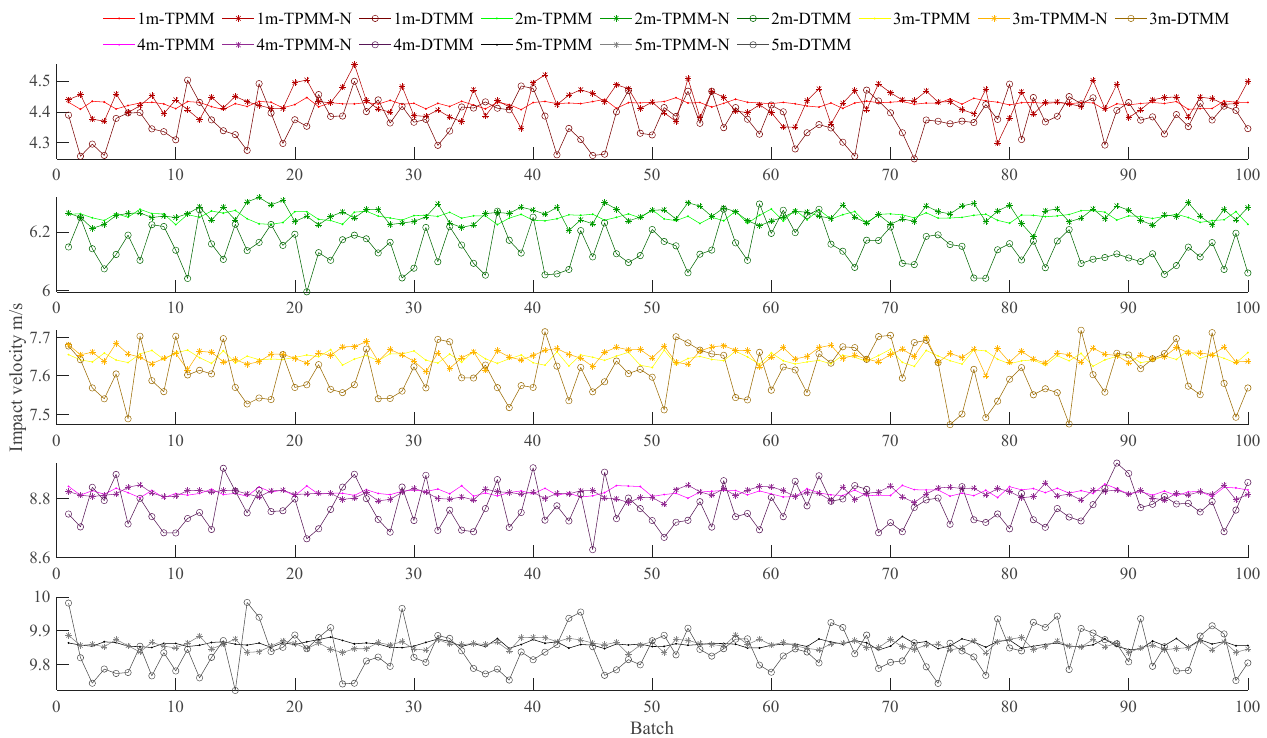
Figure 6. Simulation measurement results.